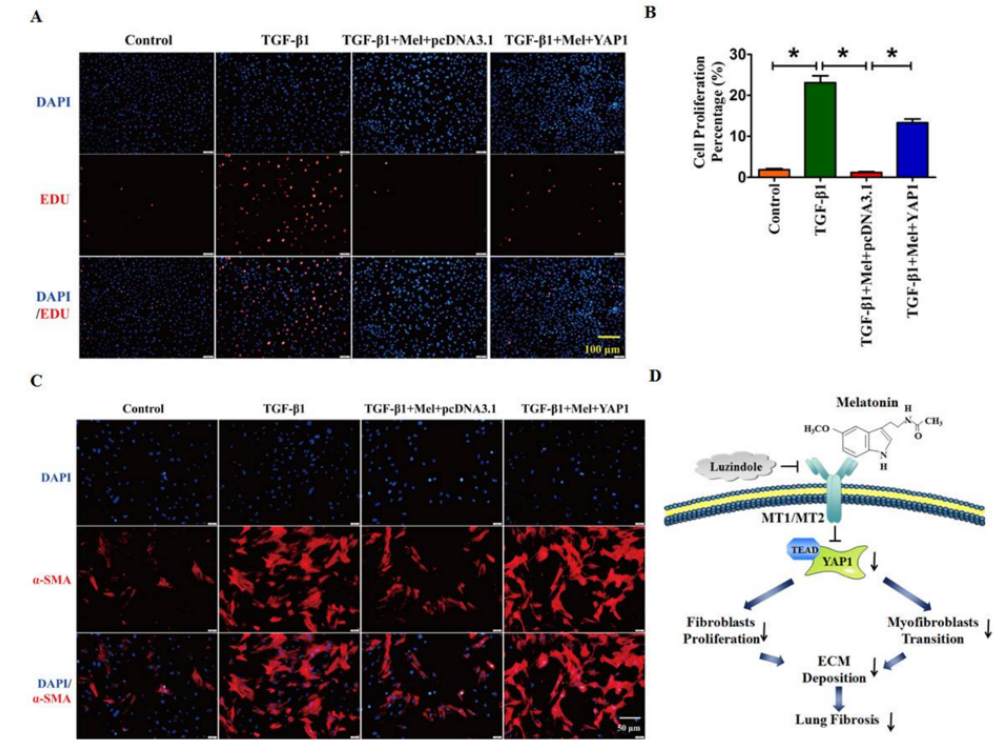
Figure 6. Overexpression of YAP1 reversed the suppression of cell proliferation and myofibroblasts activation. Microphotograph of EDU staining ( A , B ) and α -SMA positive staining ( C ) illustrated forced expression of YAP1 could rescue the anti-fibrotic effect of melatonin. ( D ) The schematic diagram of this study, melatonin alleviated lung fibrosis in vivo and in vitro via interacting with its receptor, and this anti-fibrotic effect was mediated by YAP1 inactivation. Values are the mean ± SEM of five independent experiments. * p <